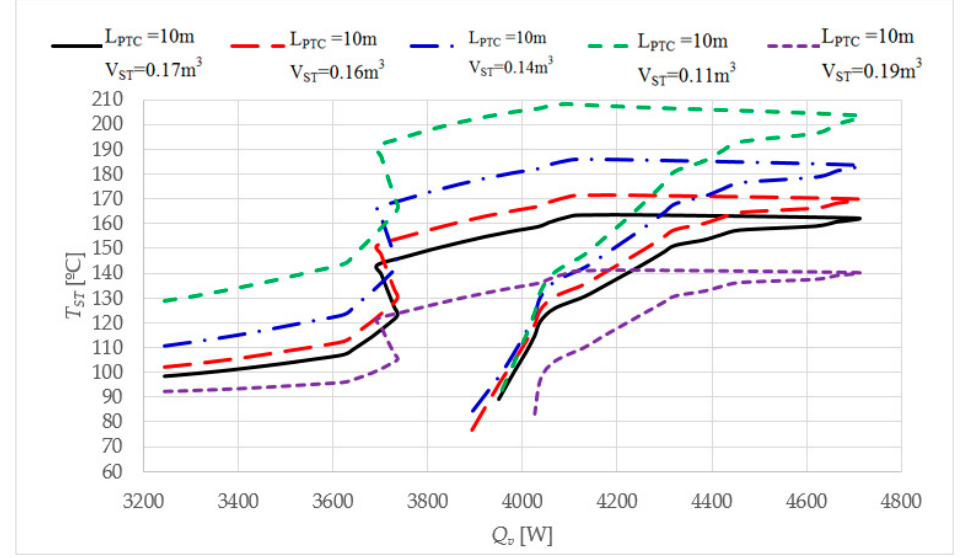
Figure 14. Storage tank temperature—cooling load dependence; sensitivity with respect to storage tank dimension.